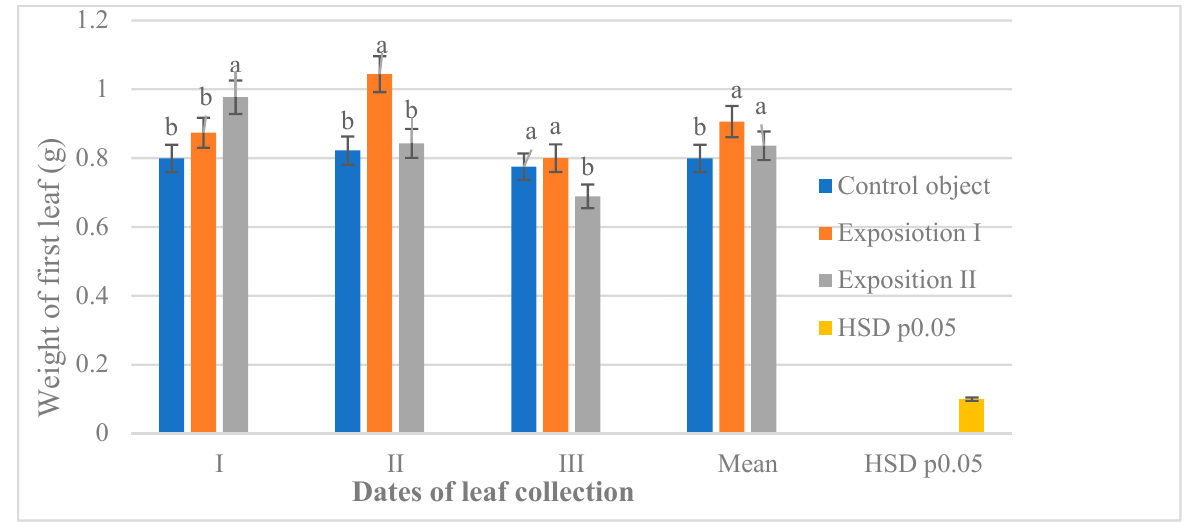
Figure 6. The effect of stimulation of seeds and harvest time on the weight of the first leaf (g) (2015–2017). I—20 days after sowing, II—40 days after sowing, and III—60 days after sowing; control object—the seeds without stimulation with FM, exposition I—the seeds were stimulated with FM for 15 s, and exposition II—the seeds were stimulated with FM for 30 s.; Letter indicators (a, b, c, etc.) next to averages refer to the so-called homogeneous (statistically homogeneous) groups. The occurrence of the same letter indicator next to the means (at least one) means that there are no statistically significant differences at p 0.05 between them.